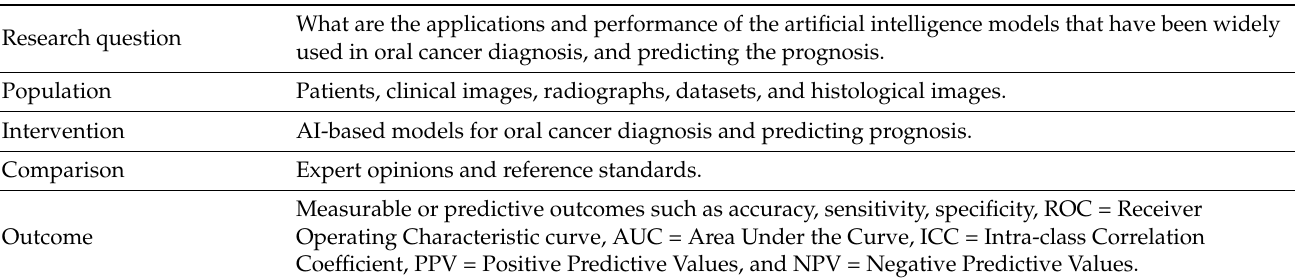
Table 1. Description of the PICO (P = Population, I = Intervention, C = Comparison, O = Outcome) elements. What are the applications and performance of the artificial intelligence models that have been widely Research question used in oral cancer diagnosis, and predicting the prognosis. Population Patients, clinical images, radiographs, datasets, and histological images. Intervention AI-based models for oral cancer diagnosis and predicting prognosis. Comparison Expert opinions and reference standards.